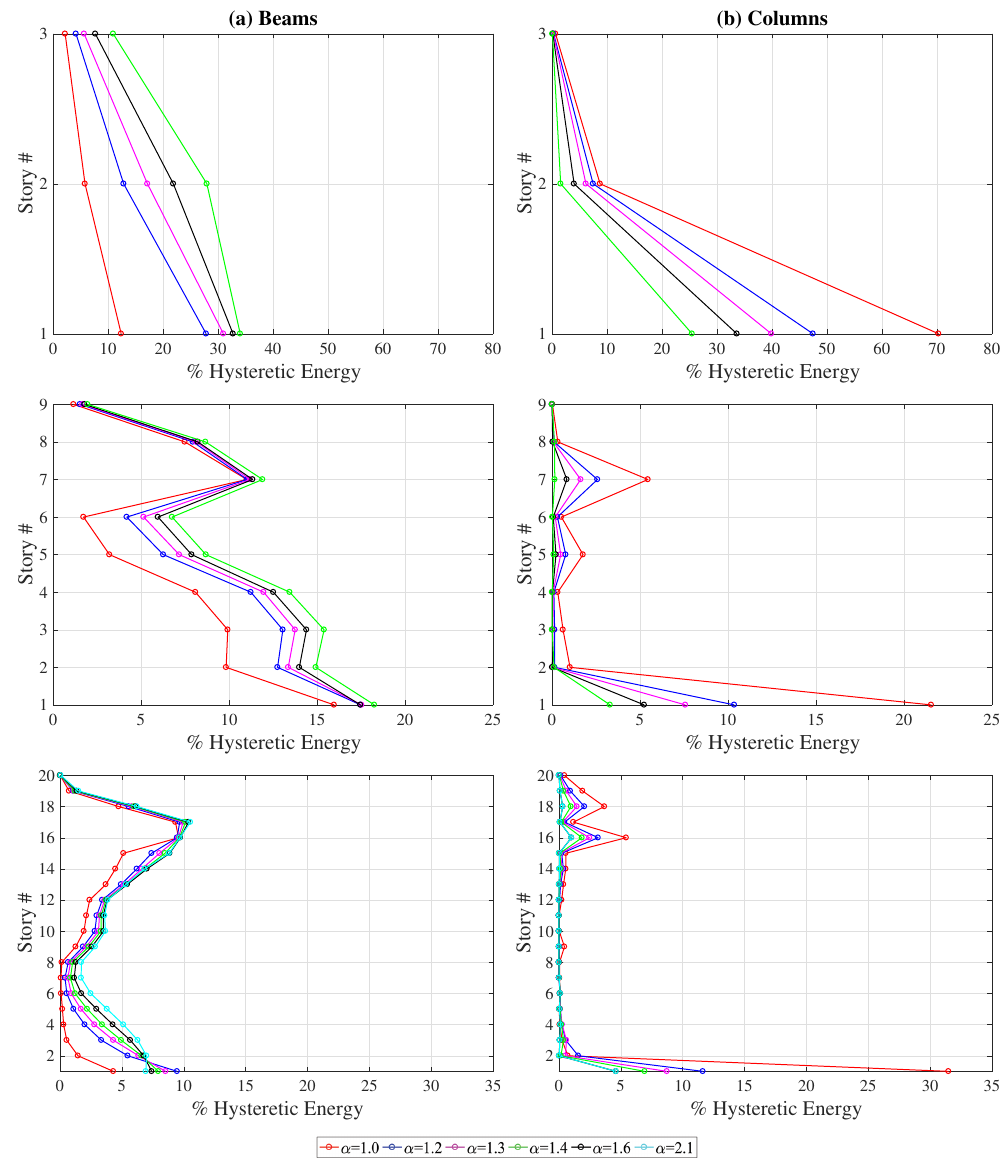
Figure 9. Variation of hysteretic energy demands over height with column-to-beam-strength ratio for ( a ) beams and ( b ) columns for the 2/50